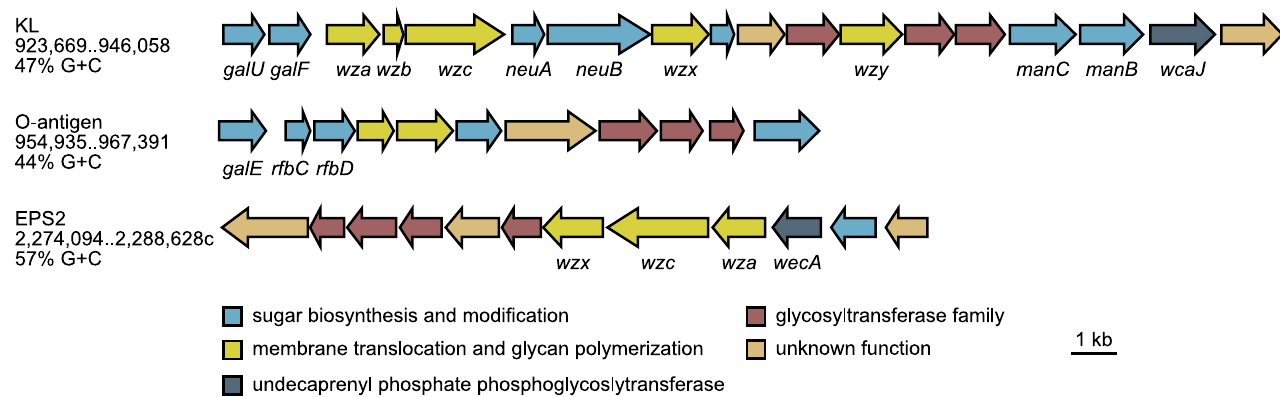
Fig 1. S . marcescens UMH9 genetic loci with predicted function in surface polysaccharide production. Genes with predicted roles in surface polysaccharide production were identified and manually annotated from the S . marcescens UMH9 genome sequence. Individual genes (arrows) are colored according to their predicted function. The coordinates and G+C nucleotide content of each locus are indicated.